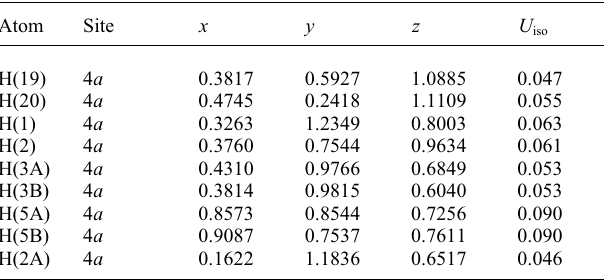
Table 2. Atomic coordinates and displacement parameters (in Å 2 ) .